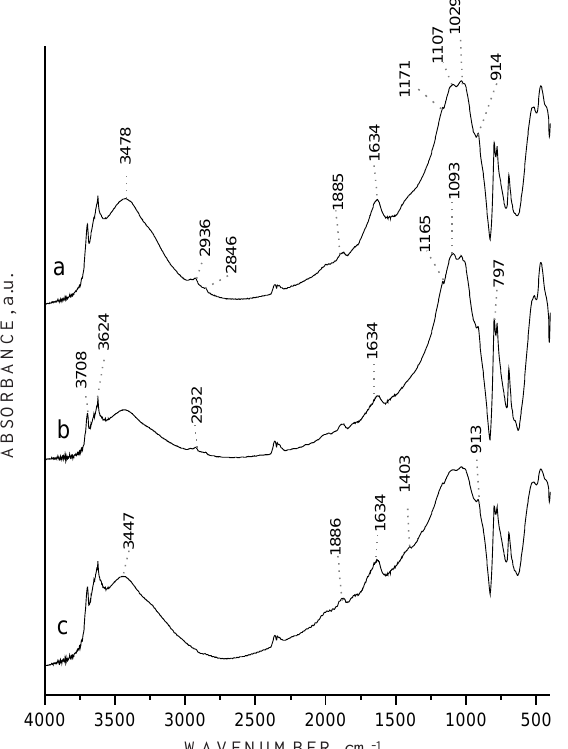
Latosol.Figure 3. Transmission FTIR spectra of the whole soil (a), of the HS-extracted soil (b) and of the oxidized soil (c) of the